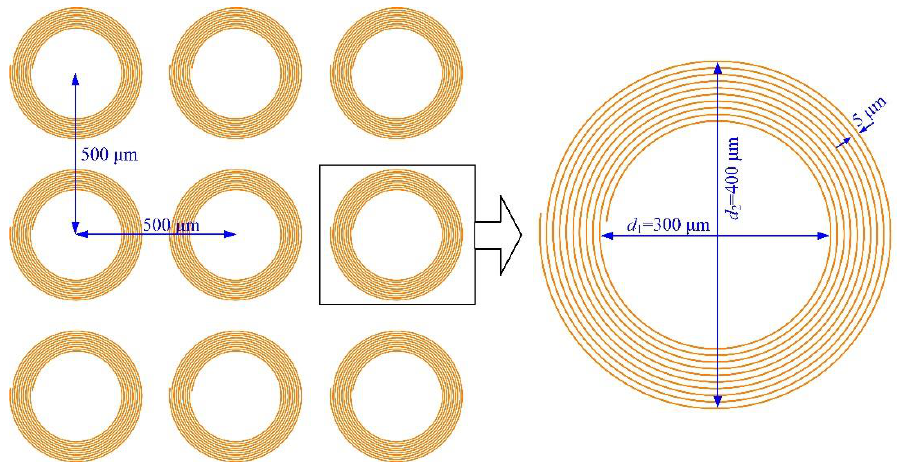
Figure 2. Spiral scanning approach to process SiC micropillars with a femtosecond laser.